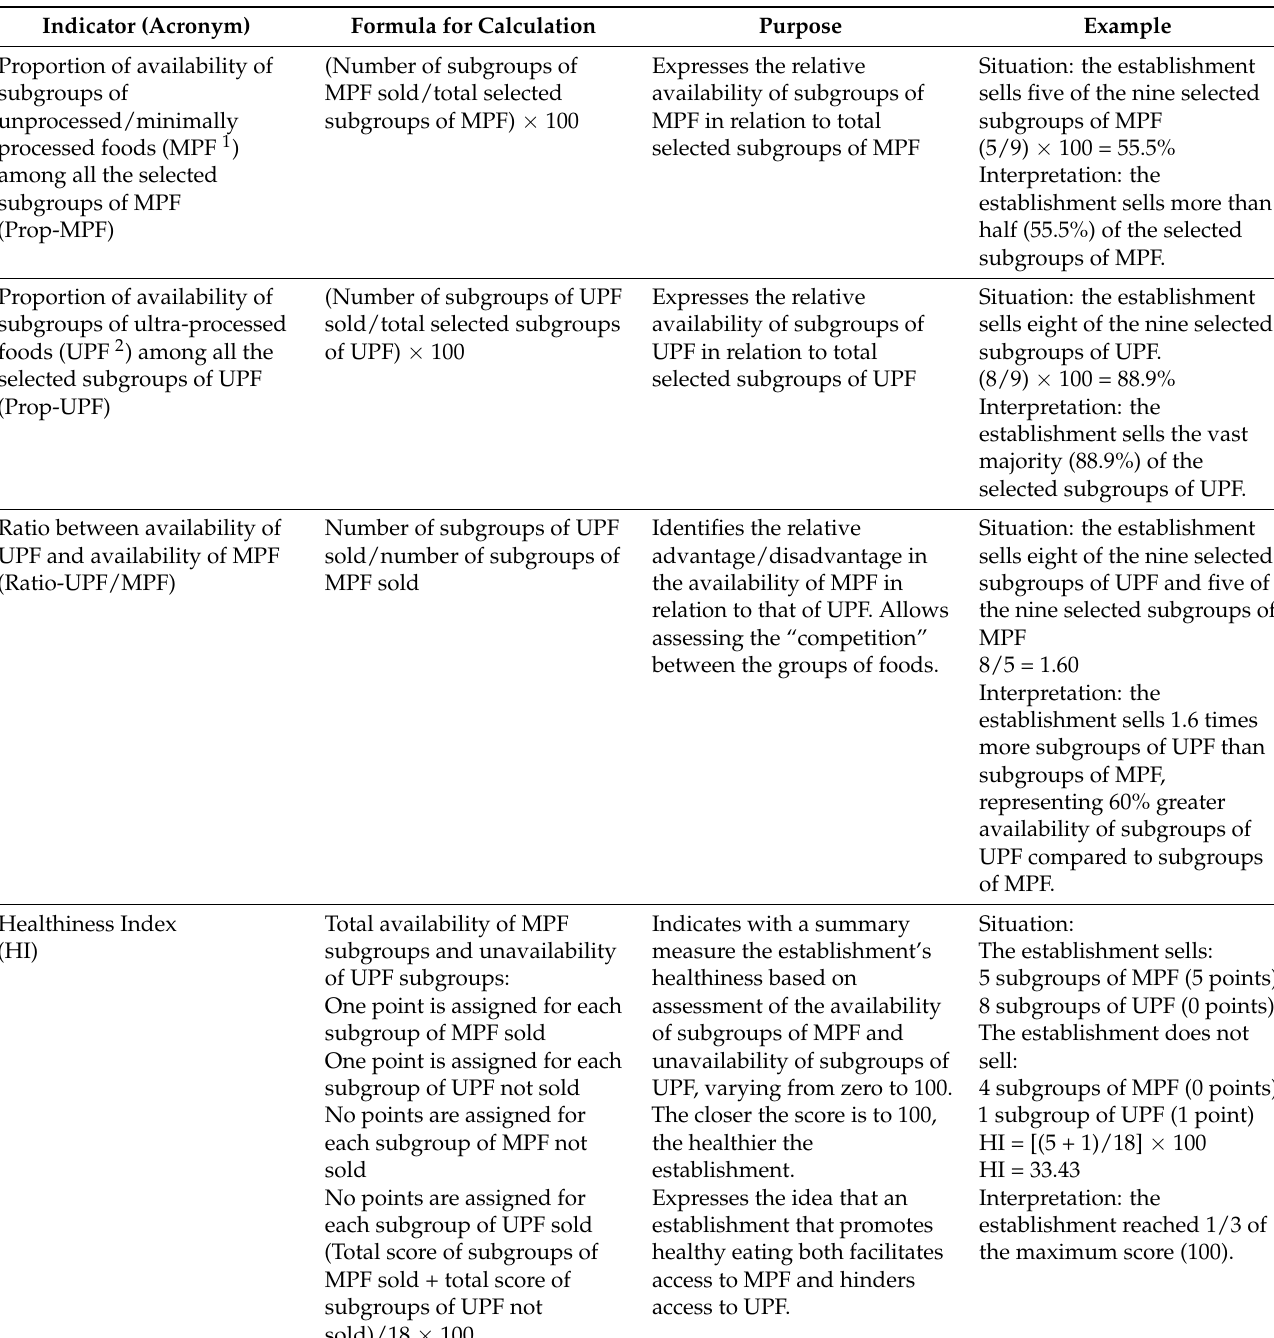
Table 1. Indicators for assessment of availability of foods in establishments that sell foods for immediate consumption